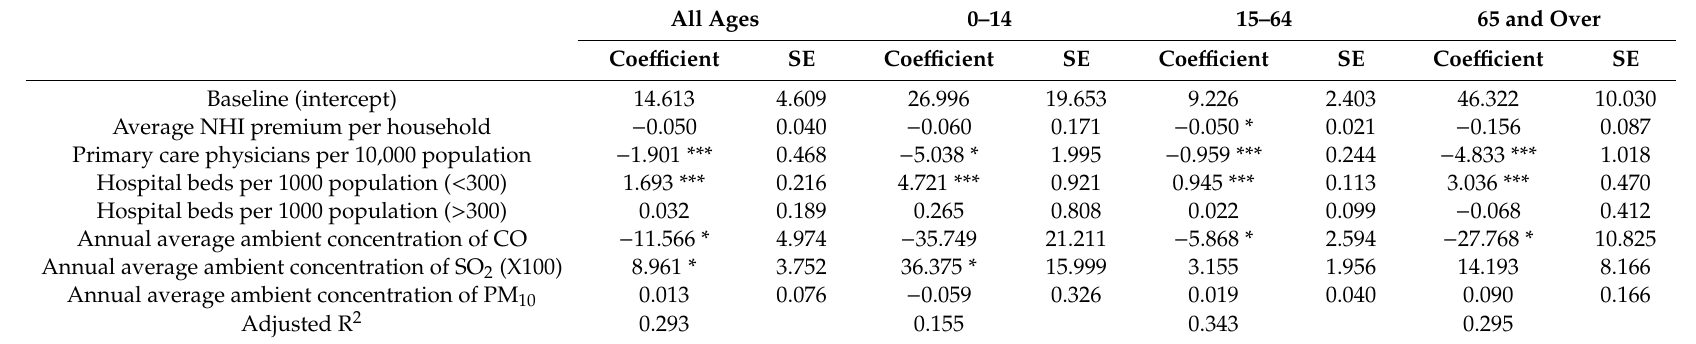
Table 4. Regression analysis of hospitalization rates for asthma by age